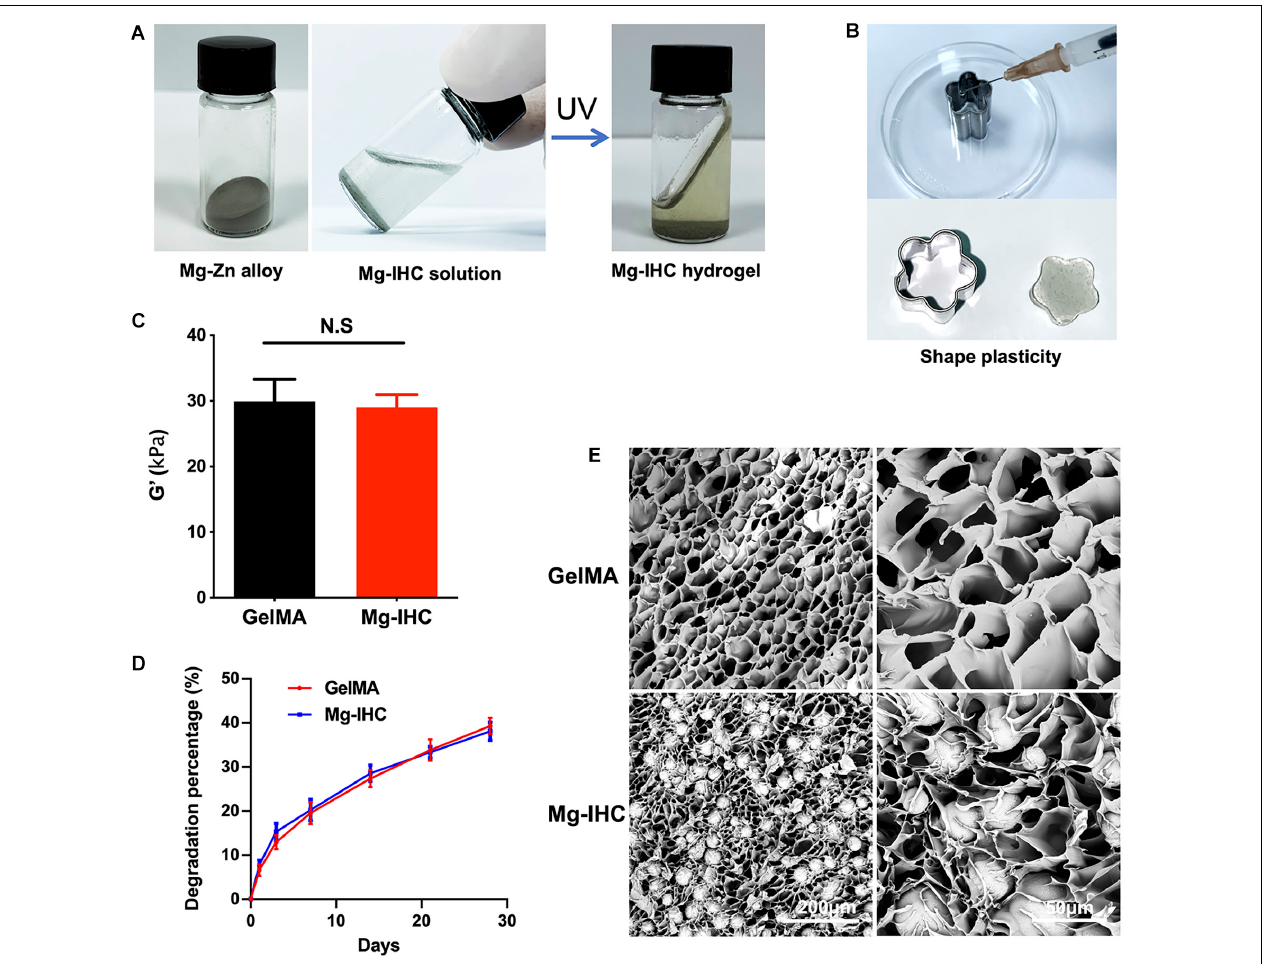
FIGURE 1 | Structure and mechanical properties of Mg-IHC. (A) Schematic illustrations of Mg-IHC formed after UV irradiation. (B) Schematic of Mg-IHC molding. (C) Elastic modulus of GelMA and Mg-IHC. (D) Degradation percentage of GelMA and Mg-IHC in vitro . (E) Scanning electron microscopy imaging of GelMA and